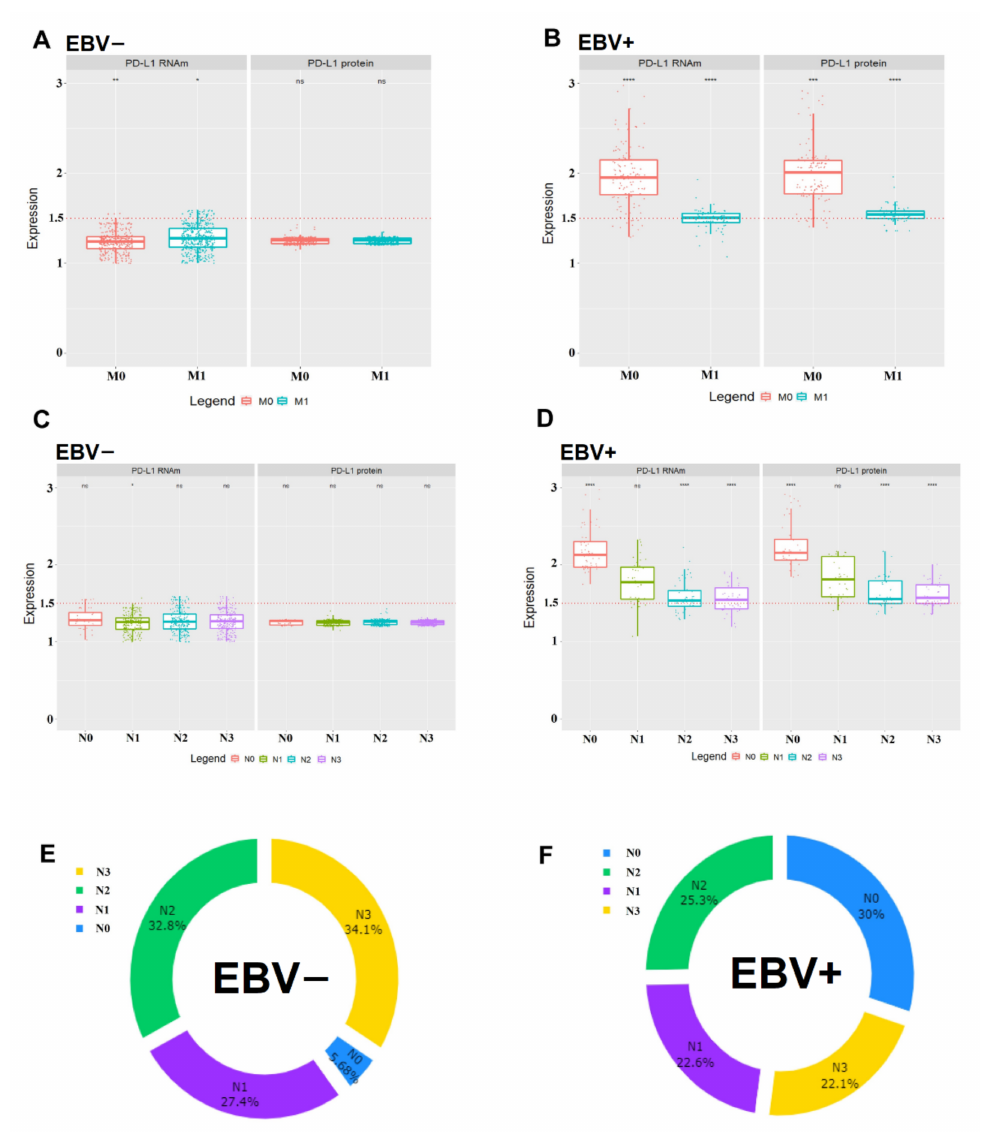
Figure 3. ( A , B ) Normalized relative expression of PD-L1 mRNA and protein in the patients’ gastric tumor tissue without metastasis (M0) and with metastasis (M1) ( p < 0.001) stratified in EBV − and EBV+ status. The 1.5-fold-change is represented by the red dotted lines. (ns, not significant, * p < 0.05, ** p < 0.01, *** p < 0.001, **** p < 0.0001) ( C , D ) PD-L1 mRNA and protein normalized relative expression in the gastric tumor tissue of patients with lymph node metastasis N0, N1, N2, and N3 ( p < 0.001). The horizontal line inside the box represents median values. Maximum and minimum values are represented by vertical lines above and below the box delineate, and the dots indicate outliers. ( E , F ) Donut Chart shows the ranking of distributions (%) in samples from EBV − and EBV+ patients with Lymph node metastasis N0, N1, N2, and